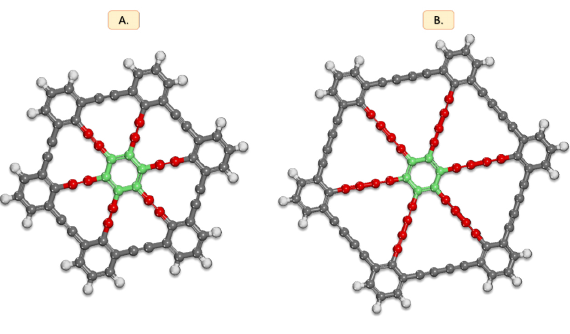
Figure 1: A. Graphyne and B. Graphdiyne structure used for DFT